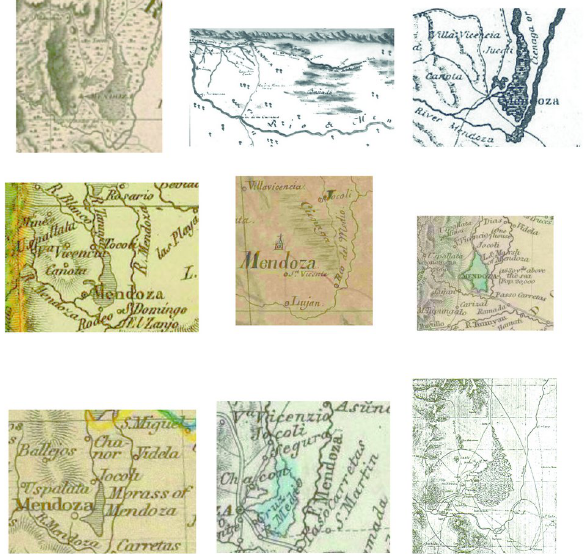
Fig. 5. Maps of the Bermejo Wetland from different years between 1794 and 1861.